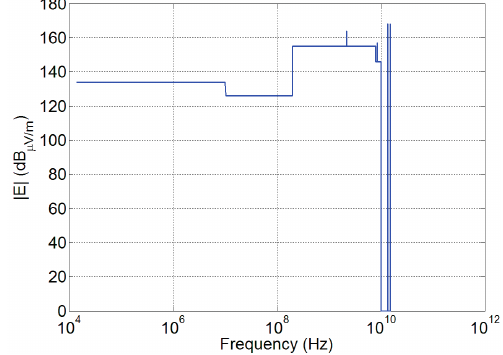
Figure 10. Susceptibility levels considered during the simulation, obtained as a worst-case combination of Columbus and Harmony EMC